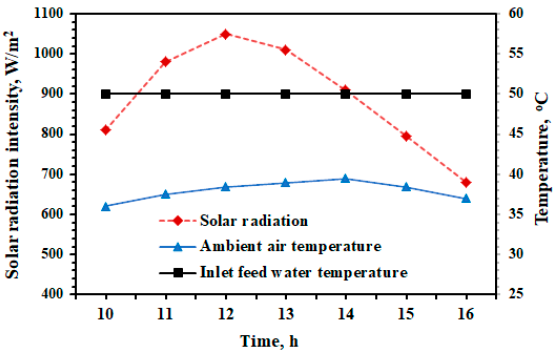
Figure 4. Variations of sunrays, ambient temperature, and feed water temperature. In the proposed system, PV panels are used to produce the electricity required to run the pumps of the desalination unit, and to increase the rates of electricity generation, a thermal recovery unit was integrated with PV panels in order to reduce the PV cell tem- perature and thus raise the rate of output electricity. At the same time, the heat recovery unit represents the fi rst preheating unit to heat the feed water before it enters a desalina- tion system. Figure 5 shows an hourly variance of maximum electricity generated by PV panels and its e ffi ciency for the cases with and without the thermal recovery system. As shown in Figure 5, during the period from 10:00 a.m. to 6:00 p.m., the maximum electricity produced by the PV panels in the case without using the thermal recovery system varied between 925 and 1065 wa tt s, but for incorporating the thermal recovery system with pho- tovoltaic panels, the rates, electricity generation was increased and ranged between 1060 and 1350 wa tt s. The rate of improvement in electricity generation reached between 0.47% and 43.6% when incorporating the thermal recovery system with photovoltaic panels. This variation in the rates of improvement in electricity generation is due to the e ff ect of chang- ing the intensity of the incident solar radiation on the PV panels and the ambient air tem- perature. Meanwhile, at 10:00 a.m. and 4:00 p.m., the cell temperature of the PV panels without cooling is low, and therefore, the amount of improvement in the rates of electric- ity generation is low in the range of 0.47%. However, with the increase in the intensity of solar radiation, the cell temperature of the PV panels rises at great rates, and therefore, the use of cooling technology is very e ff ective, as the rates of improvement in electricity gen- eration reached 43.6%. Additionally, the electrical e ffi ciency of PV panels without a ther- mal recovery system varied between 11.7% and 20.8%, but for incorporating the thermal recovery system with photovoltaic panels, the rates of electrical e ffi ciency were increased and ranged between 16.7% and 20.9%.